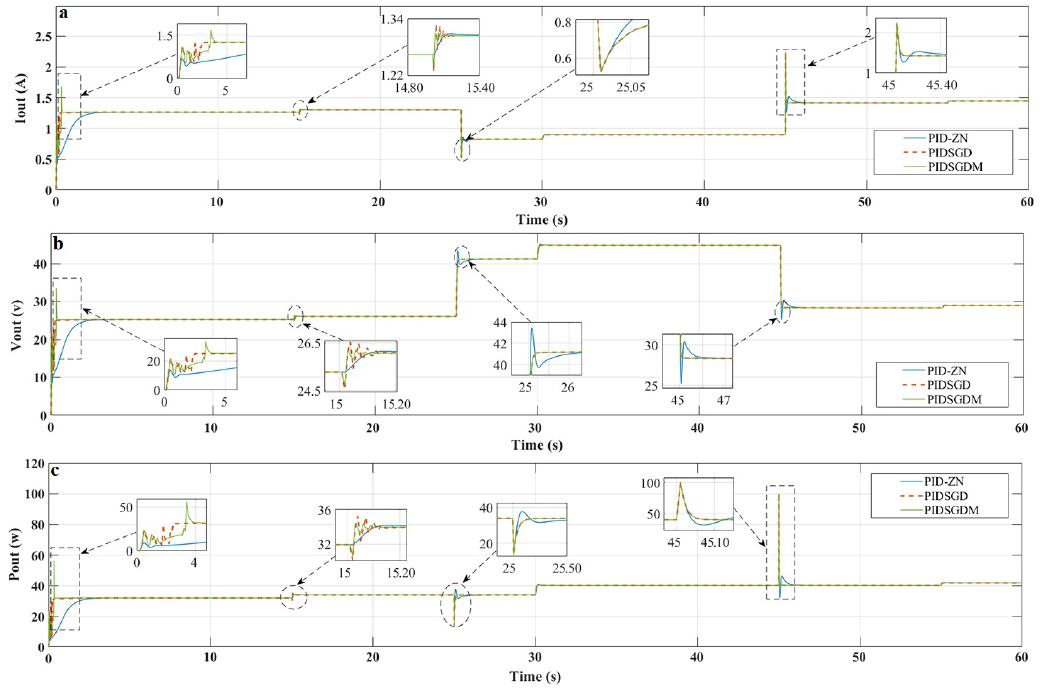
Figure 15. ( a ) Step-up converter output current; ( b ) step-up converter output voltage; ( c ) step-up converter output power.